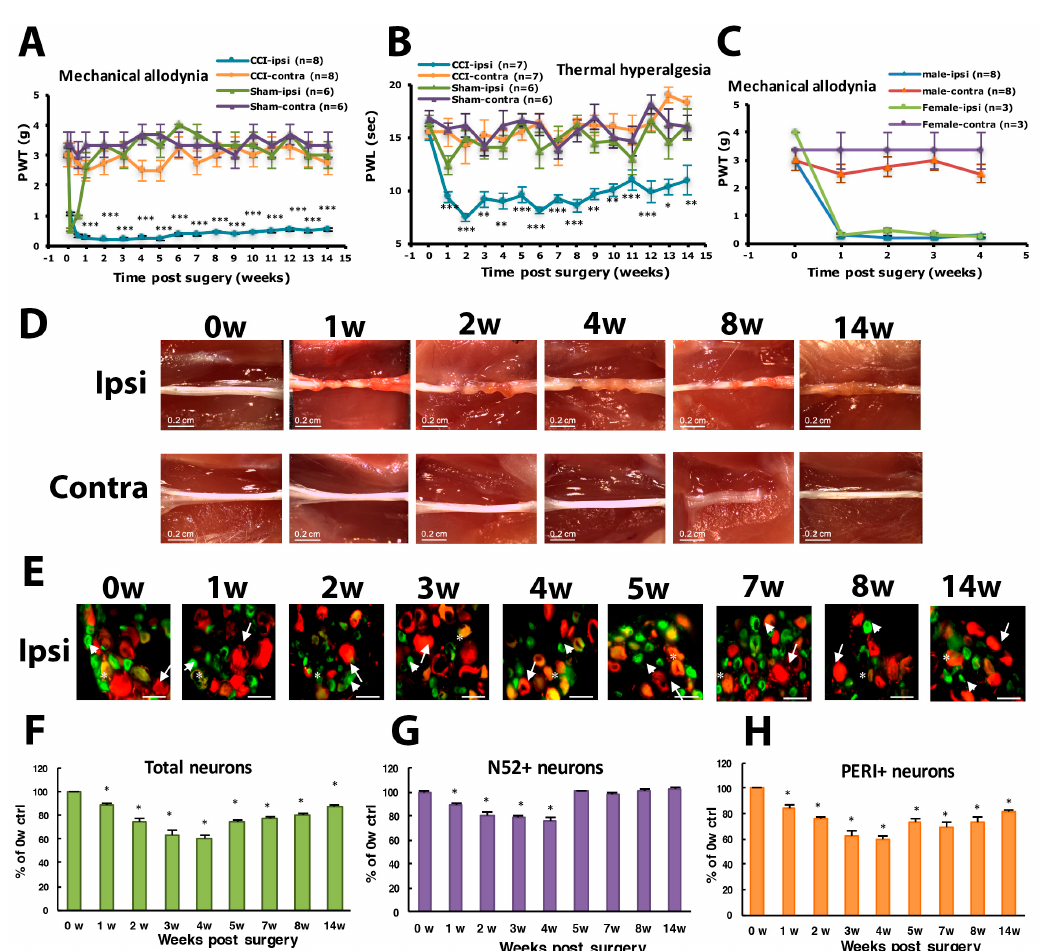
yellow color. Nerves taken 14 weeks after surgery were thick. The constriction of the sciatic nerve was associated with intraneural edema, focal ischemia and Wallerian degeneration. Cells 2020 , 9 , x